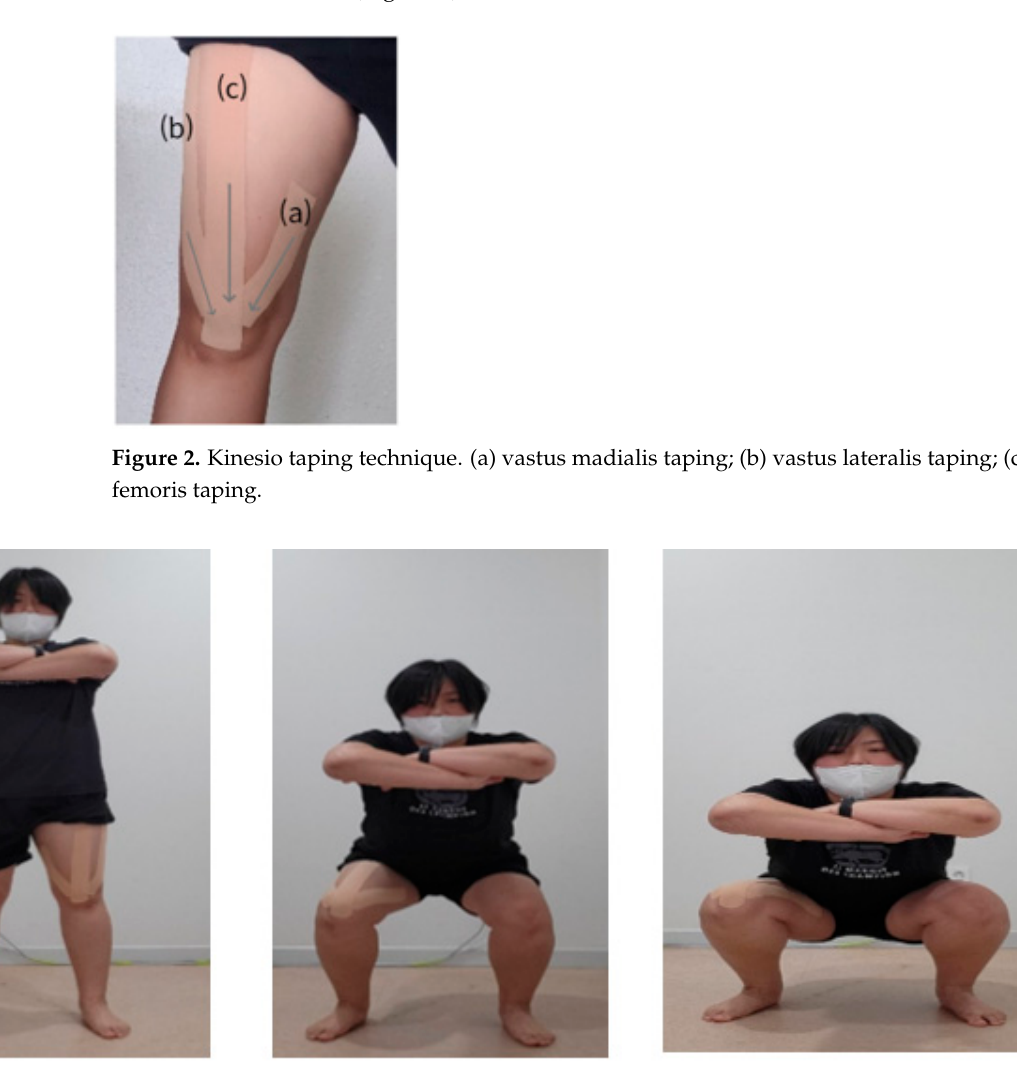
Figure 3. Kinesio taping with squat exercise.